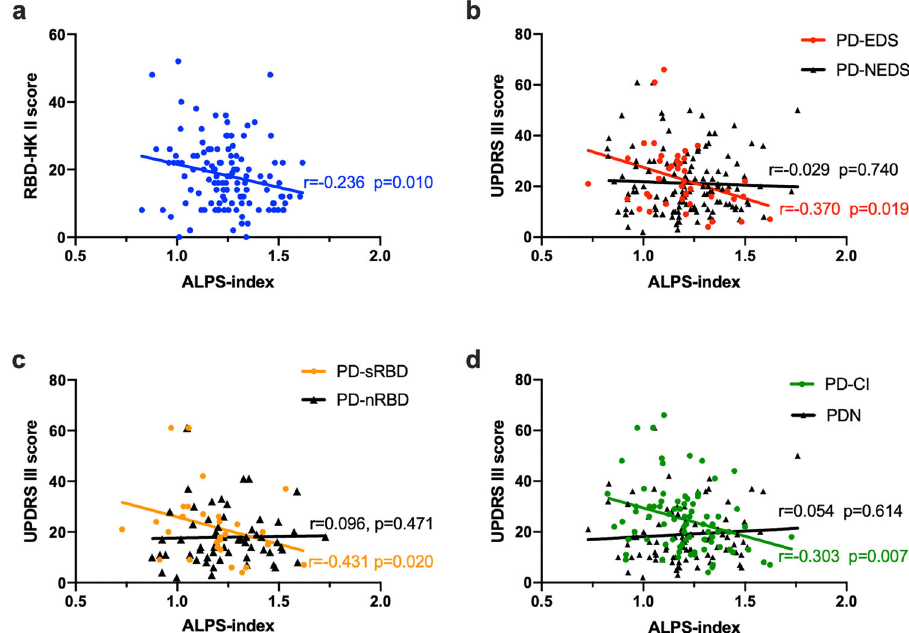
Fig. 2 Correlation between ALPS index and clinical features. Spearman correlation revealed the ALPS index is negatively correlated with the RBDQ-HK II score in piRBD group ( r = − 0.236, P = 0.010, corrected P = 0.045) ( a ), the UPDRS III score in PD-EDS group ( r = − 0.370, P = 0.019,